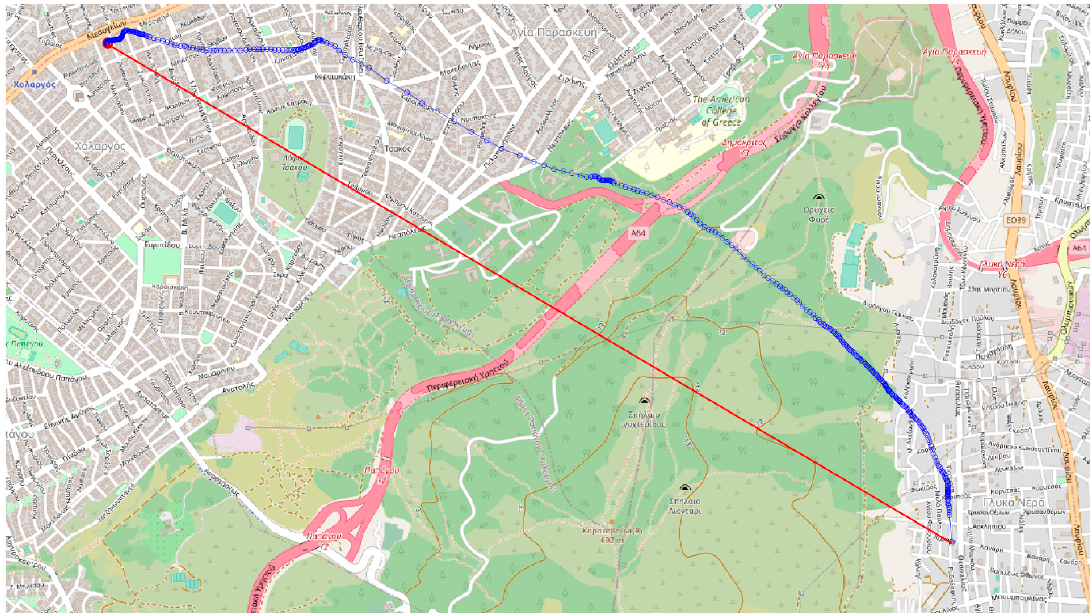
Figure 1. Optimal (red line) vs. real mouse (blue line) trajectory. Mouse records are presented as blue circles on the generated trajectory.